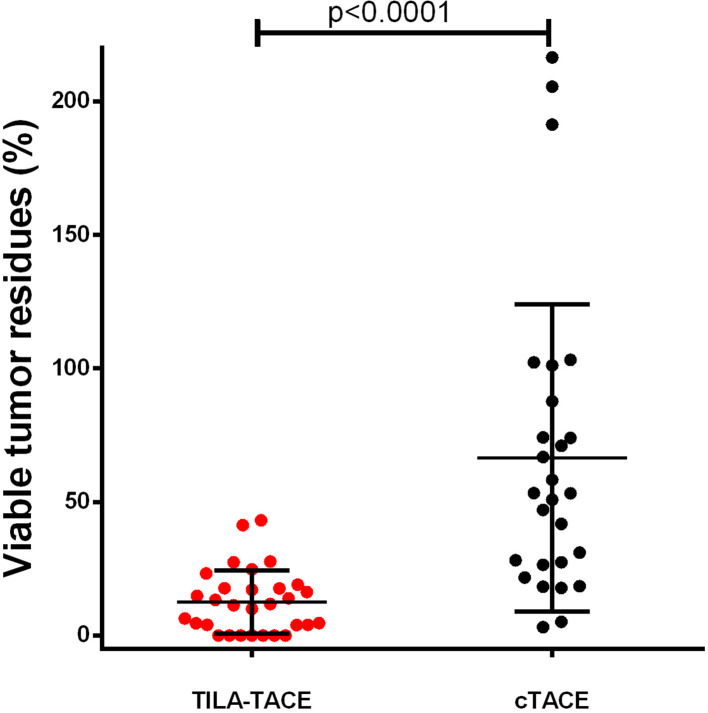
Viable tumor residues (VTR) after treatment of cTACE verus TILA-TACE.Patients’ demographic parameters were described in Table 1. The relative therapeutic improvement by TILA-TACE was 81.1%. Relative therapeutic improvement by bicarbonate is defined as [(μ1-μ2)/μ1] × (100%), where μ1 is the mean of viable tumor residues after treatment (cTACE) and μ2 the mean residual after treatment (TILA-TACE), and the maximal therapeutic improvement is 100%. Differences in VTR between two groups were statistically significant (p<0.0001), as assessed using the general linear model after adjustment for viable tumor volume before treatmentFigure 1—source data 1.Calculation of viable volume residues of each patient in the nonrandomized study after the first round treatment.